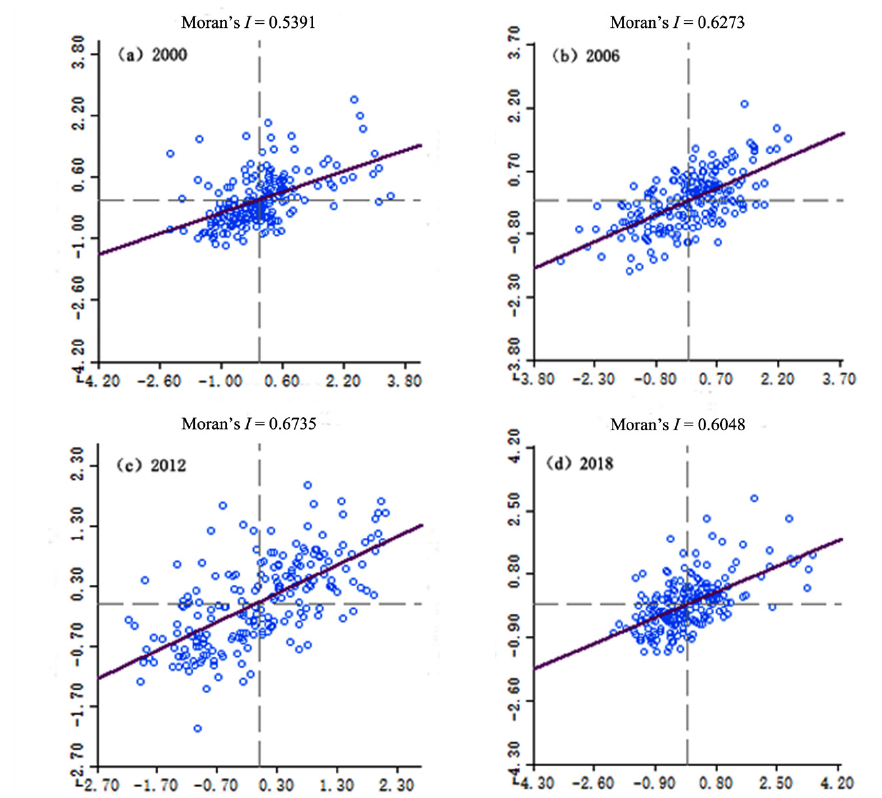
Figure 4. The Moran’ I scatter plot of landscape ecological security in Zhong